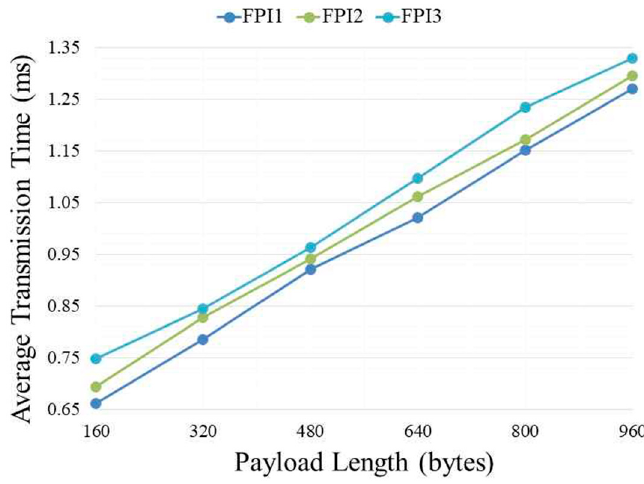
Figure 6. Packet transmission time comparison of FPI according to the number of components.